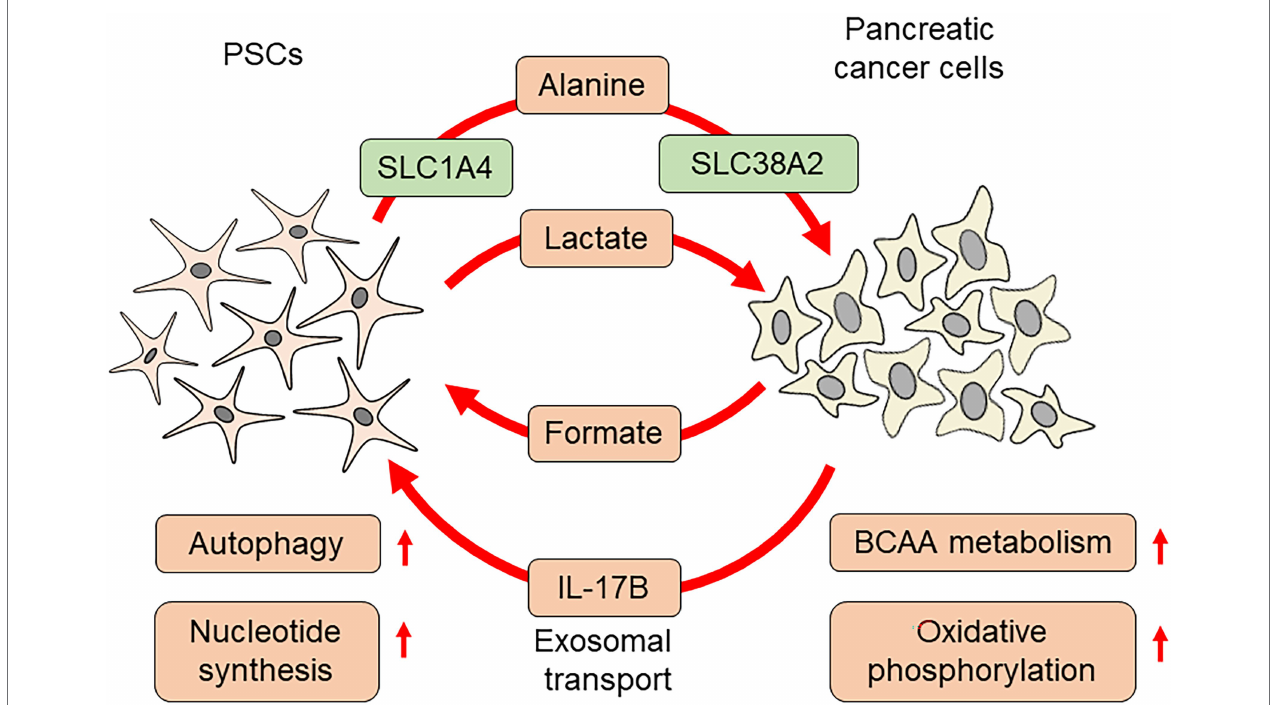
FIGURE 3 | Pancreatic cancer cell metabolism affected by